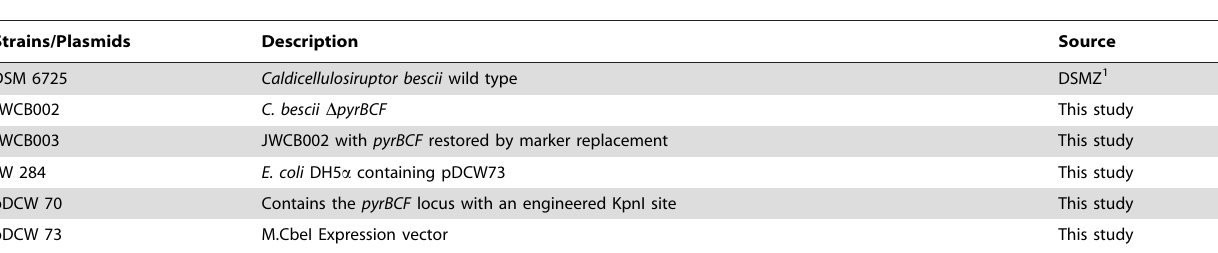
Table 1. Strains/plasmids used and constructed in this study.